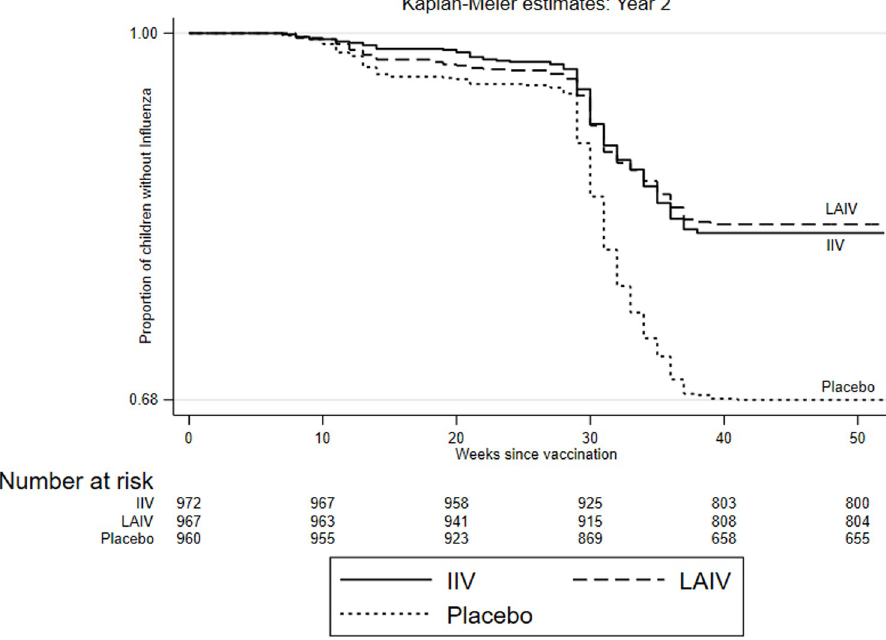
Fig 4. Kaplan–Meier curves of time to influenza infection by vaccine/placebo group for study Year 2. IIV, inactivated influenza vaccine; LAIV, live attenuated influenza